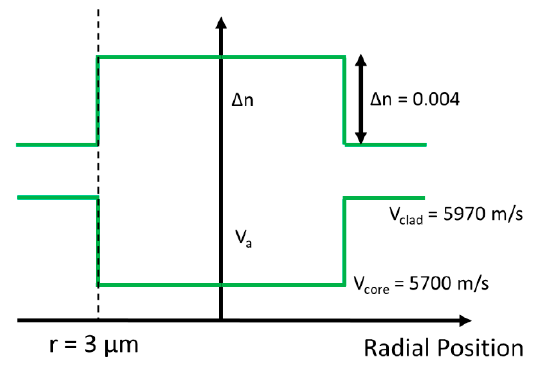
Figure 2. RIP and longitudinal acoustic velocity profile for the fiber of the example.